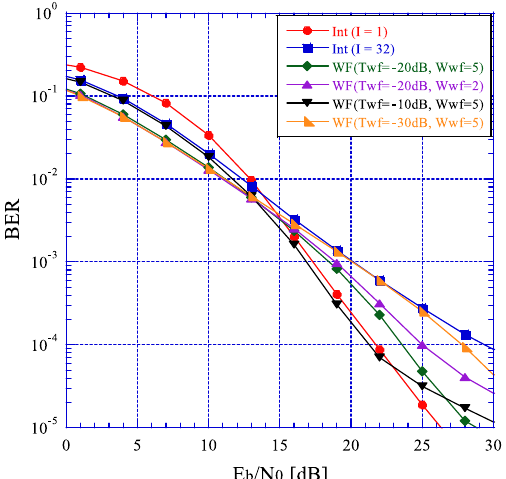
Fig. 9 BER of the various E b / N 0 for the interleaved block subcarrier allocation and the WF with the DFT and the ZF, without the